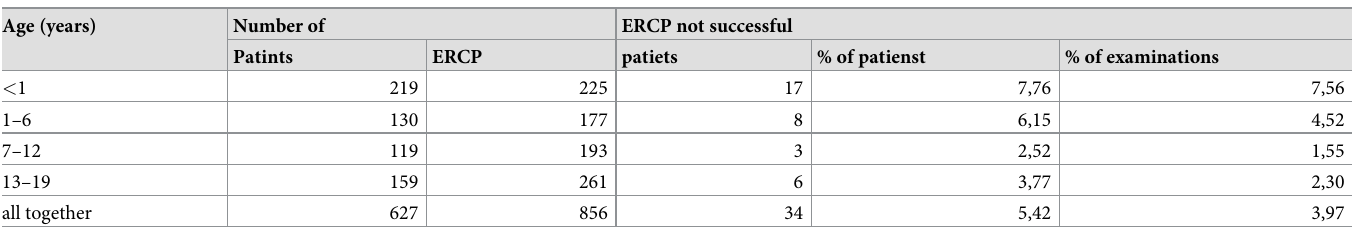
Table 2. ERCP not successful.